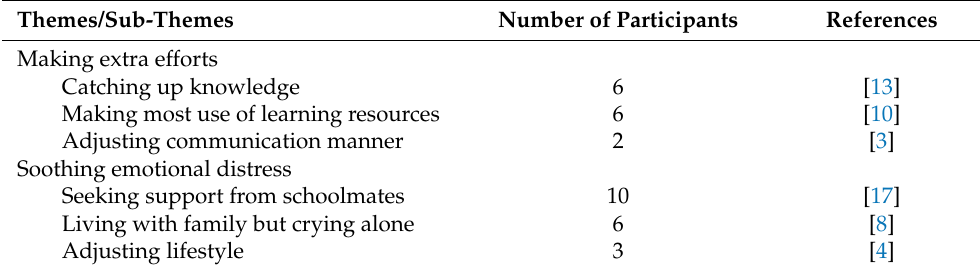
Table 2. Coping strategies used by the young nurses to deal with